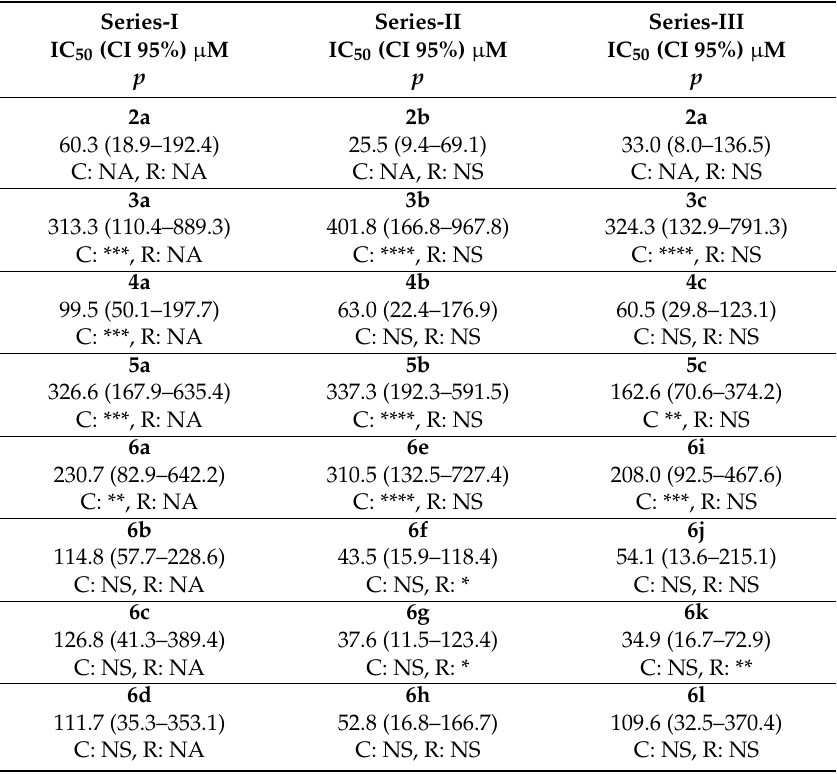
In vitro antiproliferative activities of 1 H -benzo[ f ]indazole-4,9-dione-based derivatives expressed as IC 50 values obtained in KATO-III cell